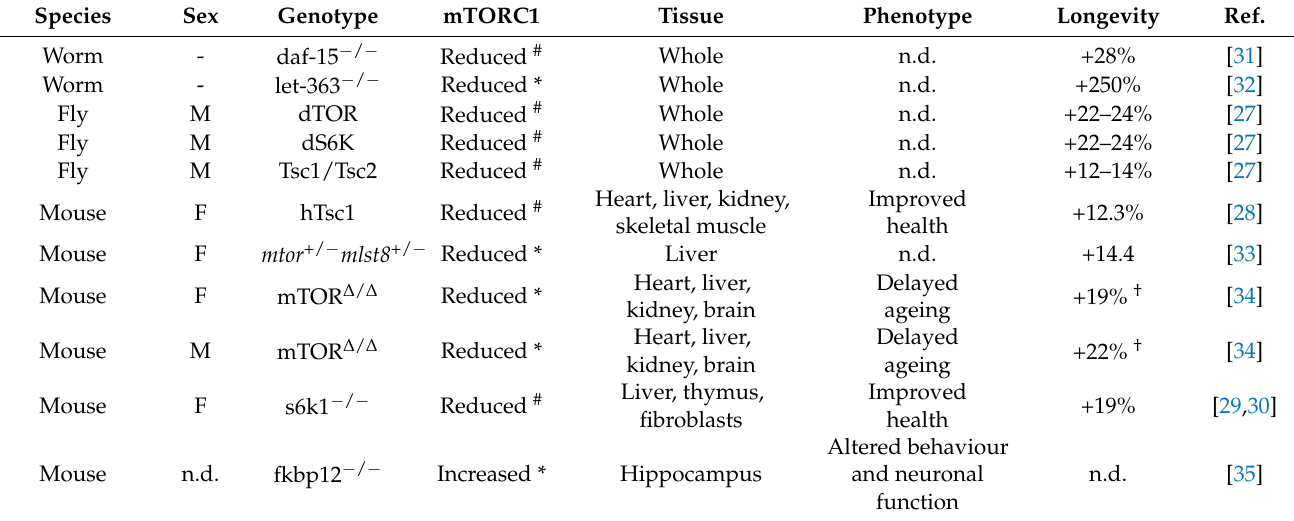
Table 2. Genetic interventions directed toward modifying the mTORC1 or mTOR signalling path- ways. Genetic interventions refer to: heterozygous knockout ( − / − ), homozygous knockout (+/ − ), dominant-negative (d), hypomorphic ( ∆ / ∆ ), overexpression (gene), and human isoform (h). In- creased or reduced mTOR content can refer to transcript content gene expression, protein content, protein phosphorylation, or activity after insulin stimulation. Longevity refers to percentage of maximum longevity (ML), in years. Letters refer to female (F); male (M); not determined (n.d.). Symbols refer to: * Studies in which expression, content, or phosphorylation of mTORC1 itself were evaluated; # Studies in which mTORC1 itself wasn’t evaluated, but its upstream or downstream effectors were. † Refers to percentage of change in average longevity (AL), in years. Phenotype Longevity